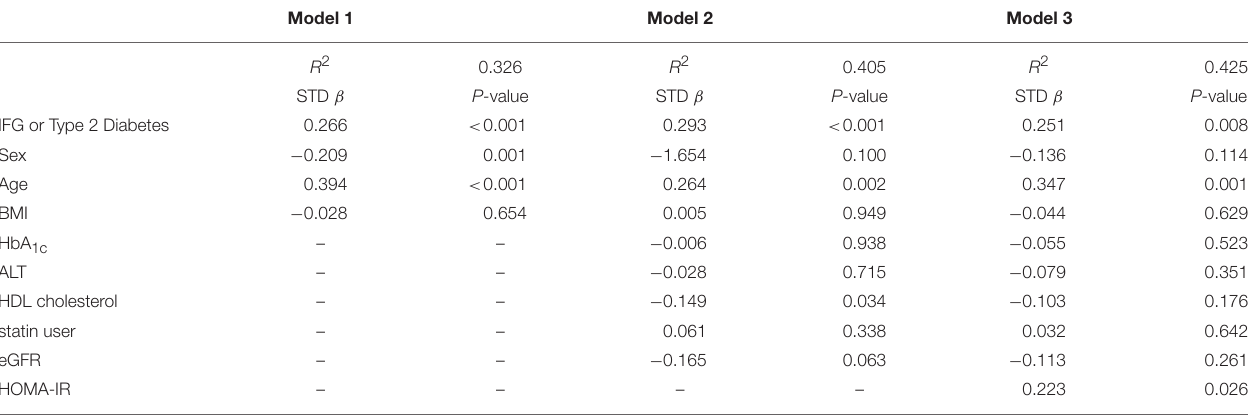
TABLE 3 | Multivariable-adjusted regression analysis of the correlation between serum netrin-1 levels and IFG or type 2 diabetes ( n =